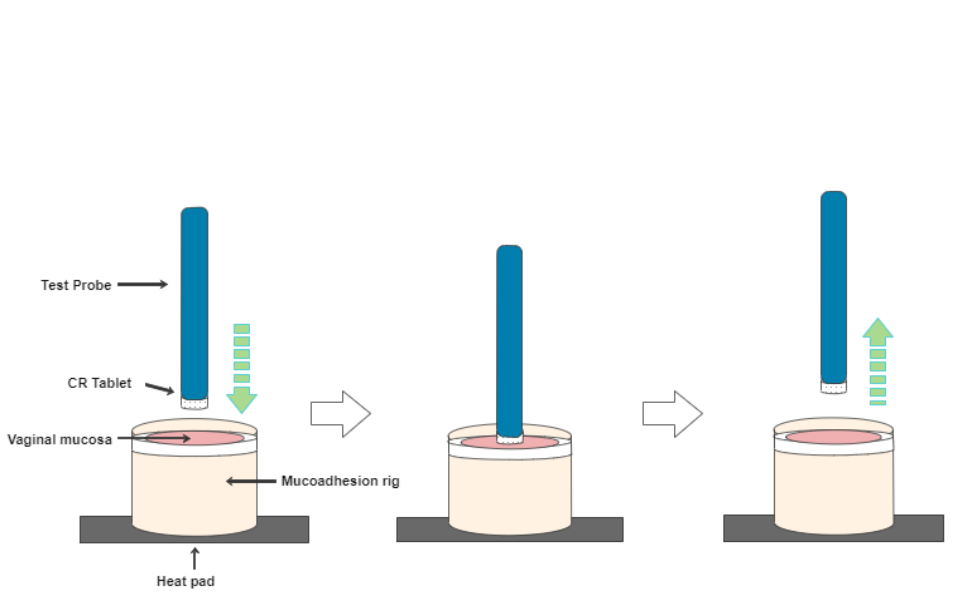
Figure 4. TA.XTplus texture analyser set up. The vaginal mucosa was cut to appropriate size to fit mucoadhesion rig support ring and the probe. Prior to testing, the vaginal mucosa was hydrated in PSVF for 15 min at 37 ± 1 °C.